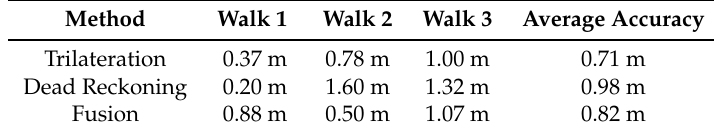
Figure 13. The detected walking paths with context information. Table 20. Positioning accuracy of final position after each trial with the context